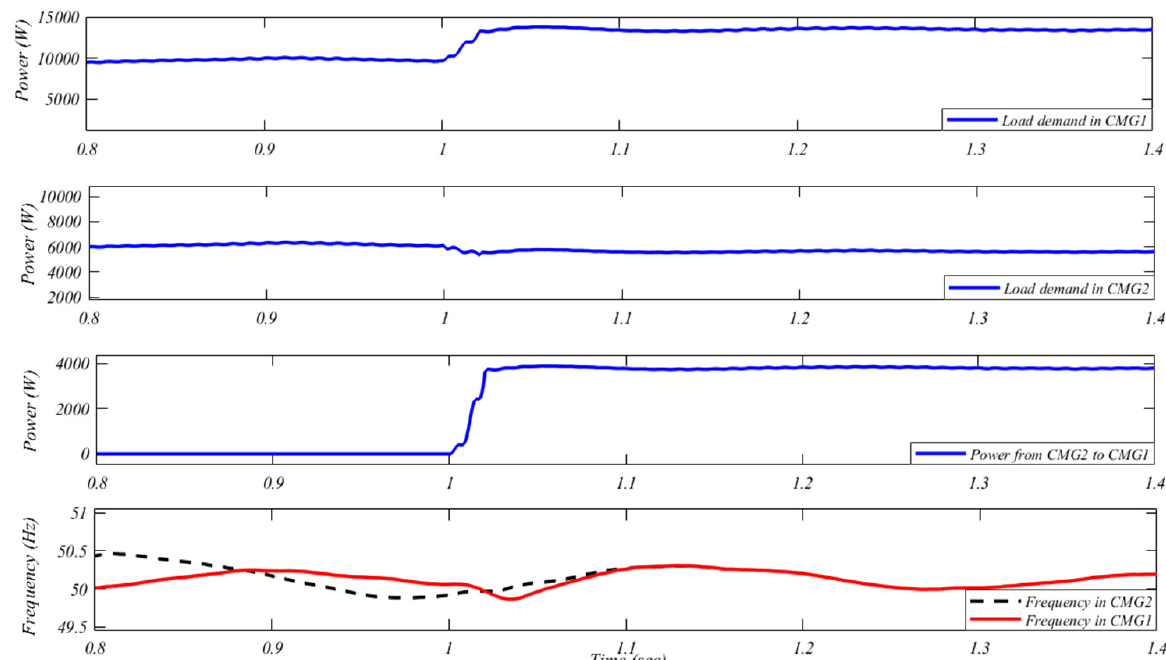
Figure 7. Active power and frequency in interconnected condition when CMG 1 is overloaded.